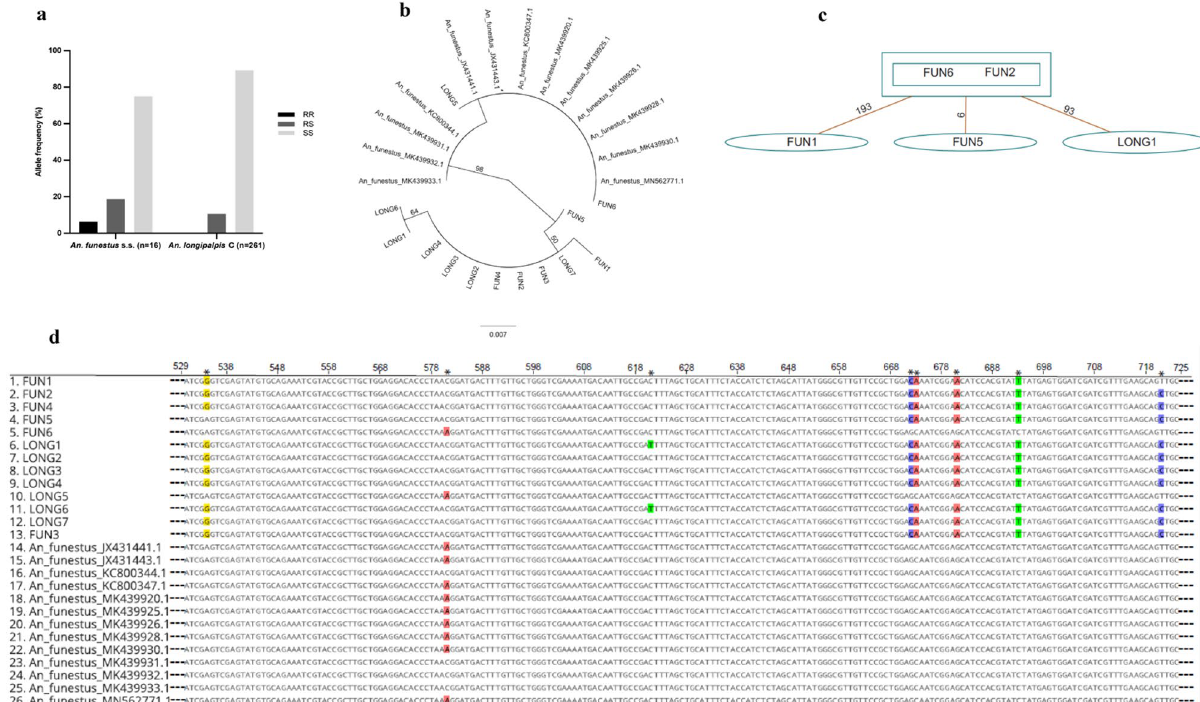
Figure 4. Analysis of the polymorphism of a portion of the glutathione S-transferase epsilon 2 ( GSTe2 ) gene. ( a ) Allele frequency distribution, ( b ) ML phylogenetic tree of GSTe2 gene fragment with previously recorded haplotypes in An. funestus s.s. across Africa, ( c ) Templeton-Crandall Sing (TCS) haplotype network. The rectangles and ovals represent haplotypes with the lines linking haplotypes showing a single mutation event. ( d ) Aligned sequence traces showing the mutational differences/polymorphic positions in the haplotypes detected in Kenyan An. longipalpis C/ An. funestus s.s. * indicates polymorphic